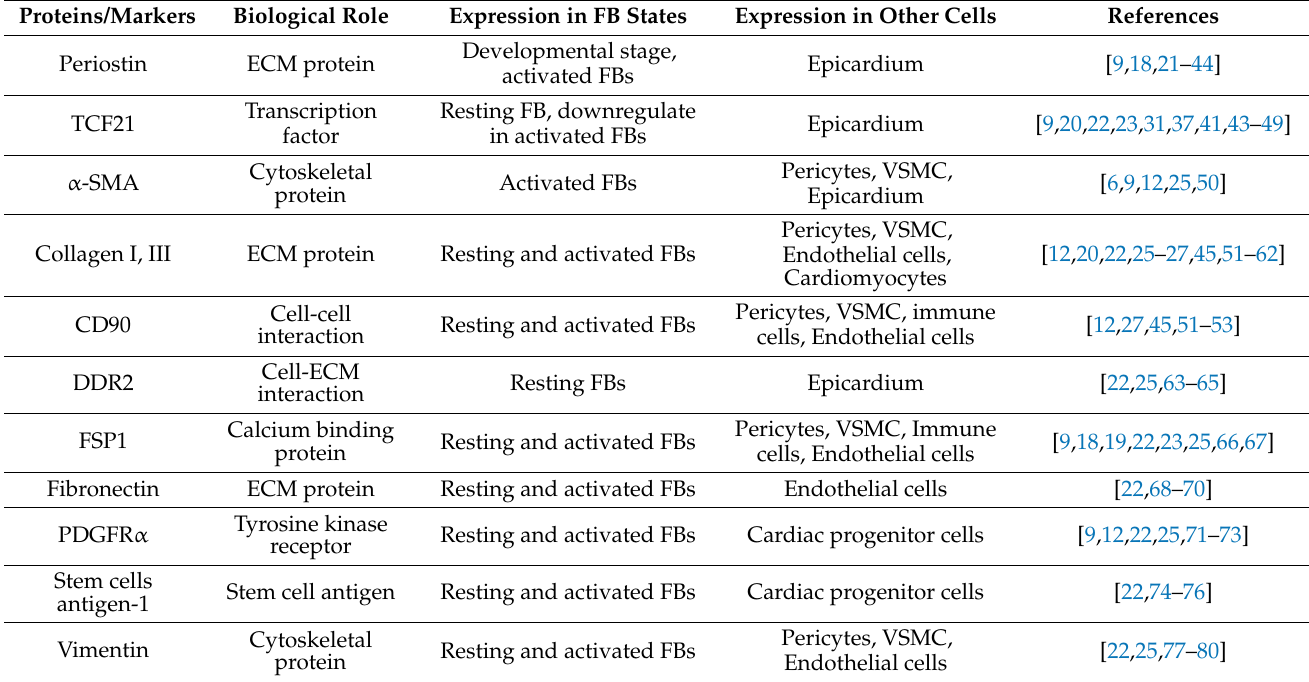
Table 1. List of proteins/markers that have been targeted in order to create mouse lines for FB-specific genetic manipulation and lineage